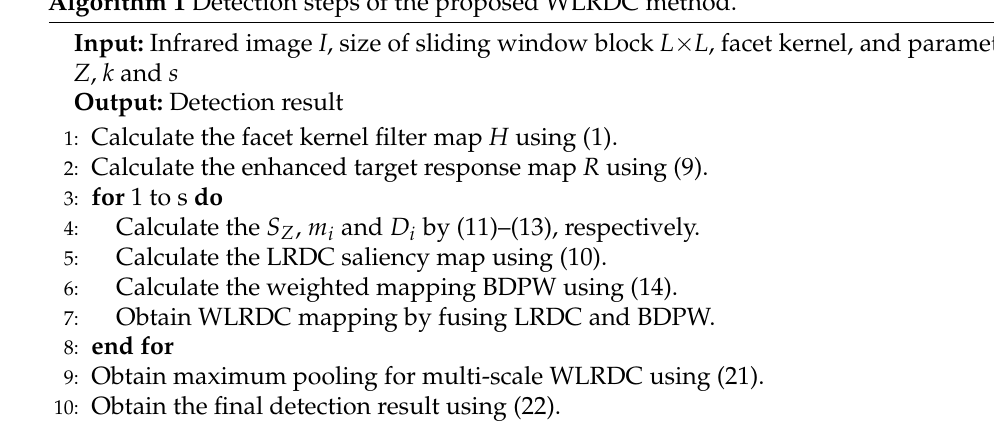
Algorithm 1 Detection steps of the proposed WLRDC